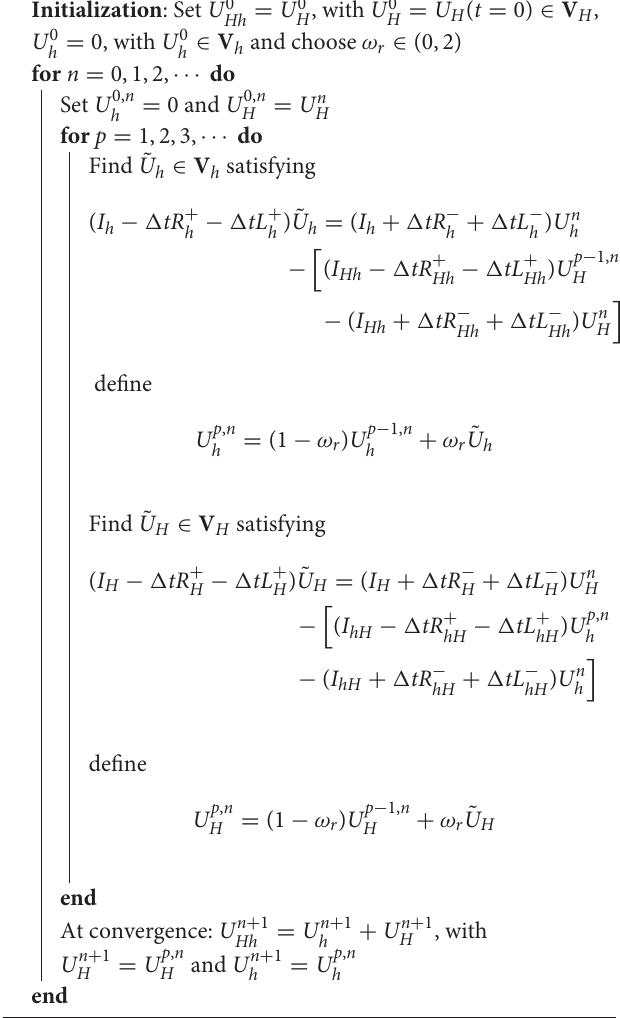
Algorithm 2: Patch algorithm applied to the weak formulation of the Yee scheme when using only a single